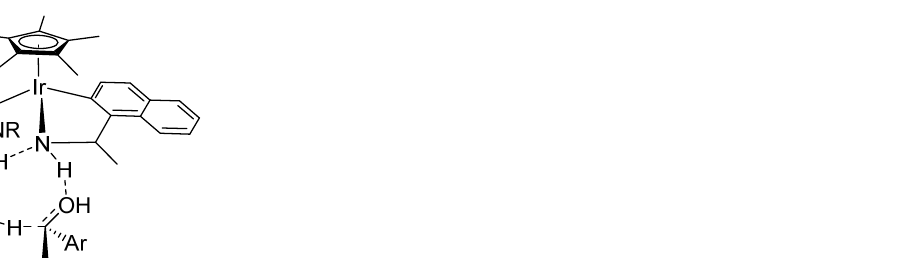
Figure 2. Transition state for MPV mechanism in ATH catalyzed by 74a and 74b .